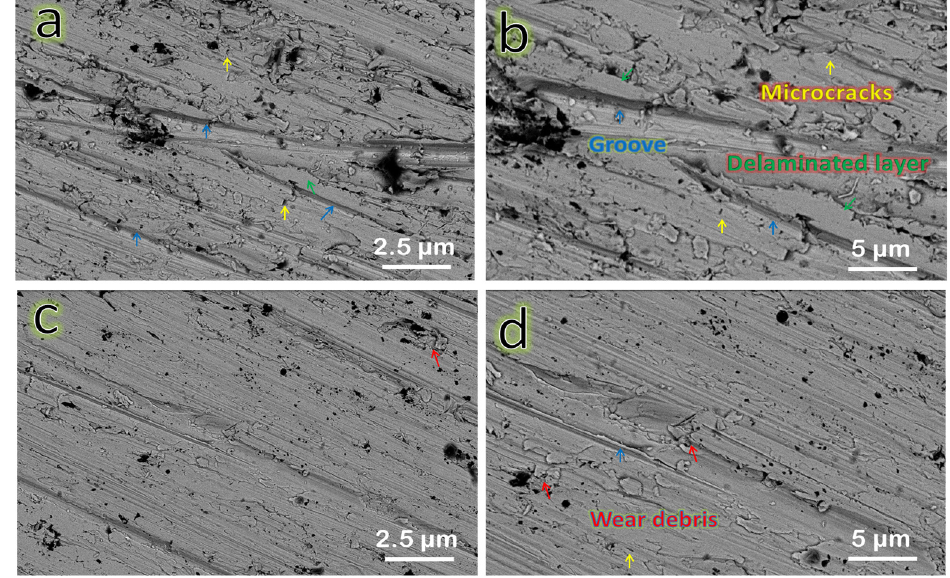
Figure 15. SEM images of wear tracks for the FNG0 sample at ( a ) lower magnification and ( b ) higher magnification and for the FNG8 sample at ( c ) lower magnification and ( d ) higher magnification powers.